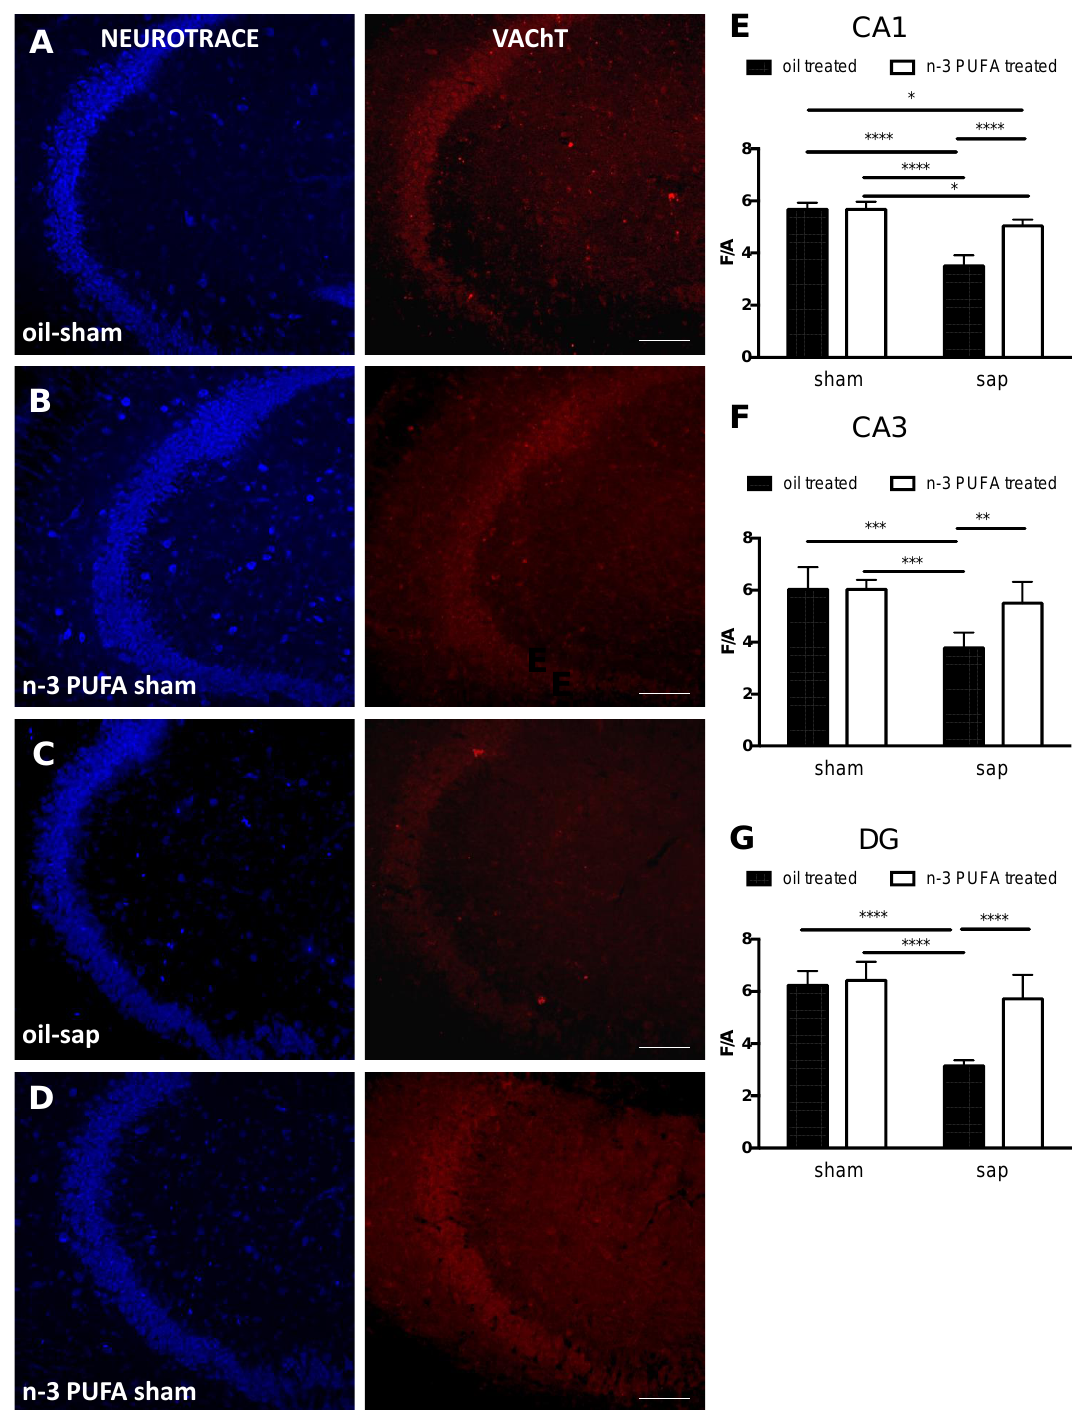
Figure 6. Densitometric hippocampal VAChT expression. ( A – D ). Confocal images from the hippocampus, namely CA3 region, of oil sham, n-3 PUFA sham, oil sap and n-3 PUFA sap mice stained with Neuro-trace (blue) and VAChT (red) showing the expression of VAChT immunostaining. ( E – G ). Representative densitometric graph of the expression levels of VAChT in CA1 ( E ), CA3 ( F ) and dentate gyrus (DG; G) of oil sham, n-3 PUFA sham, oil sap and n-3 PUFA sap mice. The F / A ratio defines mean fluorescence of individual samples ( F ) normalized to total Area ( A ). Data of the four experimental groups are depicted as mean and SEM (n = 5 / group). * p < 0.05, ** p < 0.01, *** p < 0.001, **** p < 0.0001. Scale bar: 50 µ